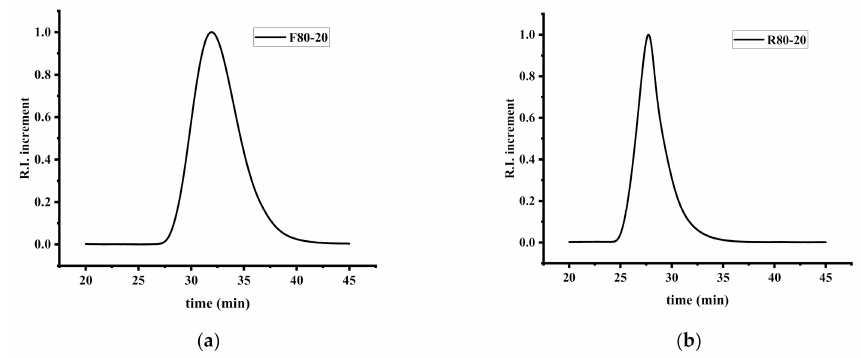
Figure 1. SEC chromatograms of the samples ( a ) F80/20 and ( b ) R80/20.